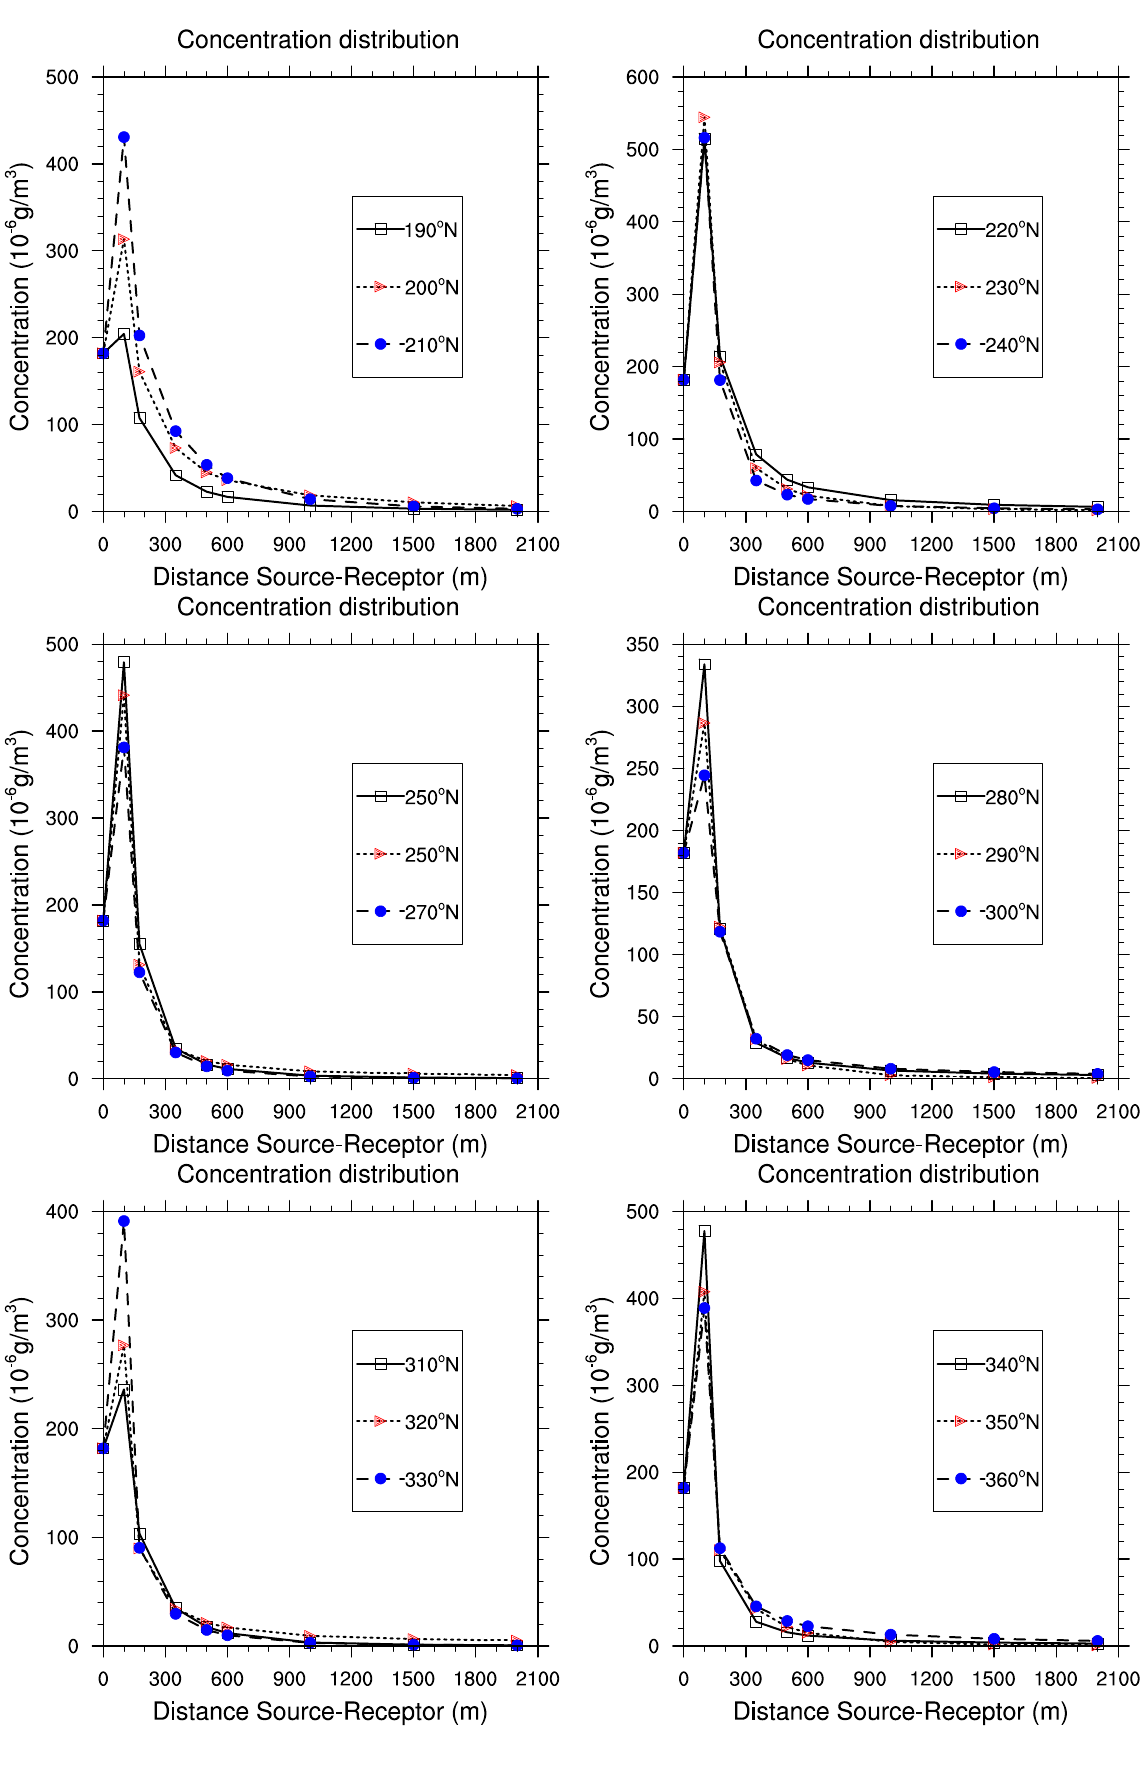
Figure 11. Same as Figure 10, but different as far as the buildings specific direction is concerned